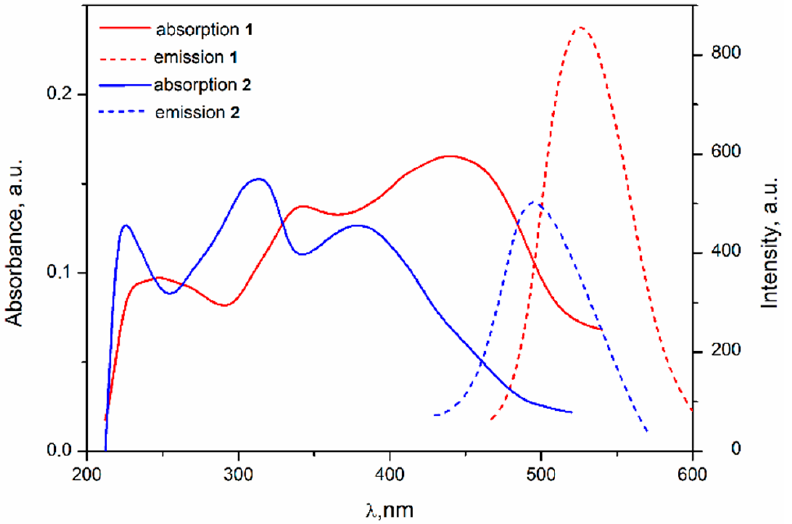
Figure 8. Solid state UV-Vis absorption (solid lines) and emission (dashed lines) spectra of complexes 1 (red) and 2